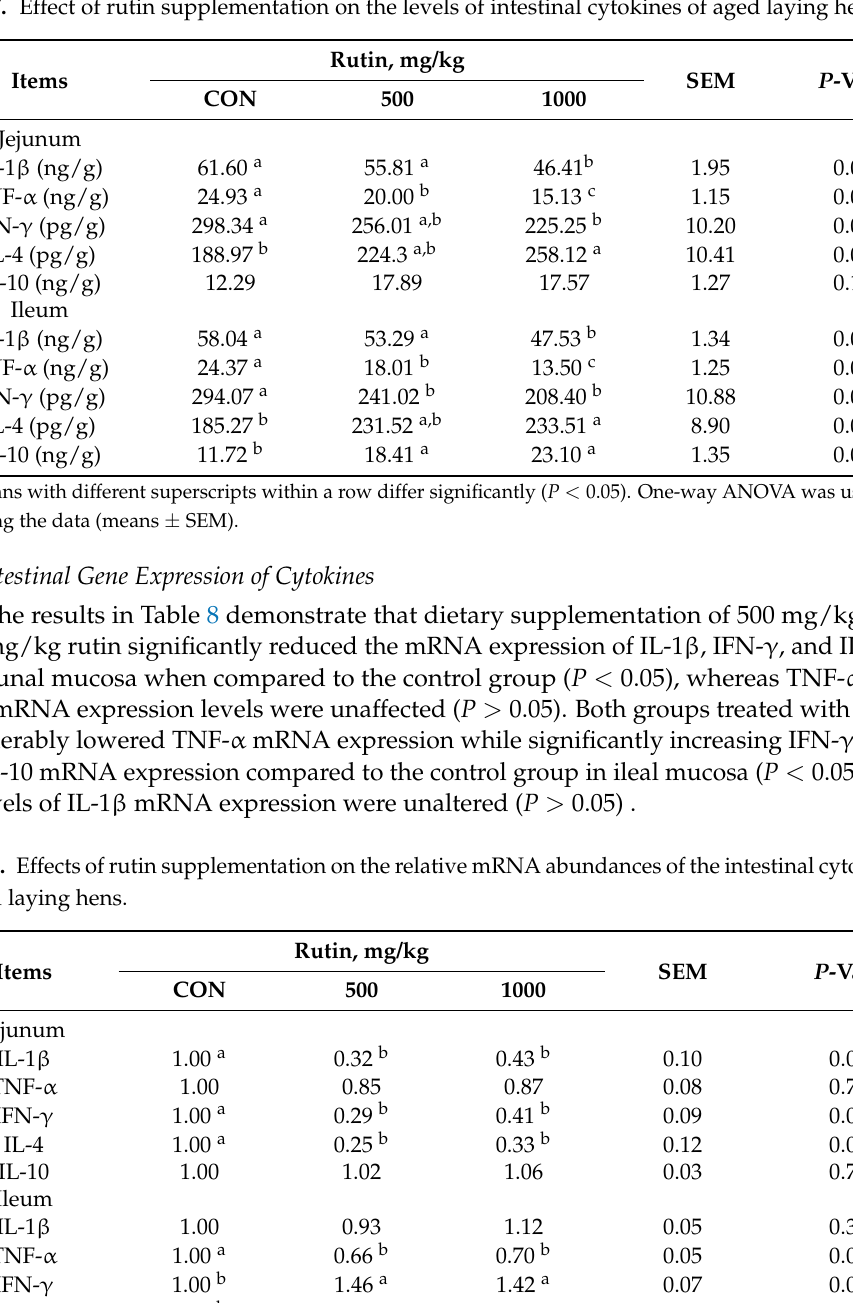
Table 7. Effect of rutin supplementation on the levels of intestinal cytokines of aged laying hens.